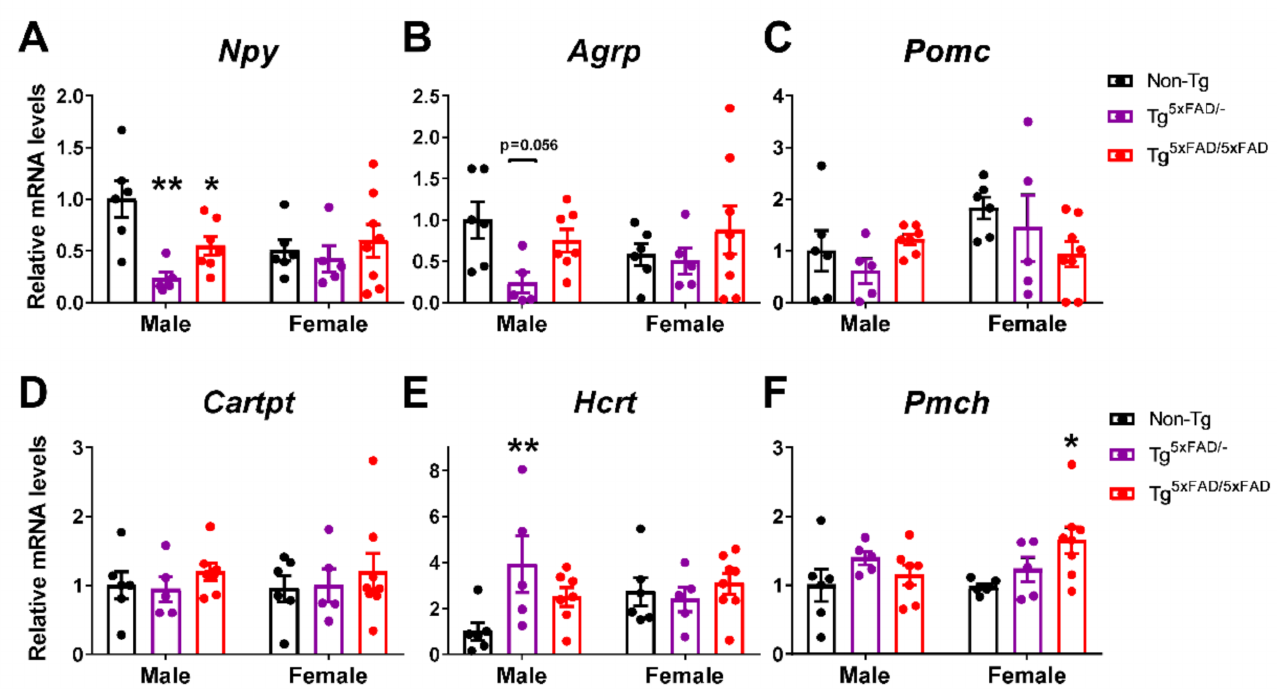
Figure 8. Hypothalamic orexigenic neuropeptide expression was decreased in 5xFAD males accompanied by altered orexin expression in males and MCH expression in females. ( A – F ) Representative quantification of expression of hypothalamic neuropeptide Y ( Npy ), agouti-related peptide ( Agrp ), pro-opiomelanocortin ( Pomc ), cocaine and amphetamine-regulated transcript prepropeptide ( Cartpt ), orexin (hipocretin; Hcrt ), and ppre-melanin concentrating hormone ( Pmch ) assessed by qPCR ( n = 5–8 per group). Non-Tg males were set as 1 for relative mRNA units. Two-way ANOVA analysis with Tukey’s post hoc test: * = p < 0.05, ** = p < 0.01 versus same-sex non-Tg